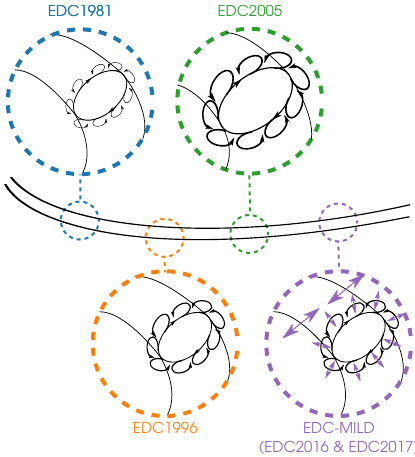
Figure 1. Schematic view of the different Eddy Dissipation Concept (EDC) modifications available in literature. indicates the fine structures, while represents the mass transfer between them and the surroundings. illustrates the variable fine structure fractions and mass transfer intensities occurring in the EDC modifications for Moderate or Intense Low oxygen Dilution (MILD) combustion. Symbol sizes indicate their relative